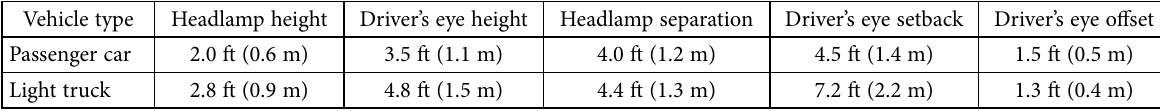
Table 2. Vehicle dimensions for